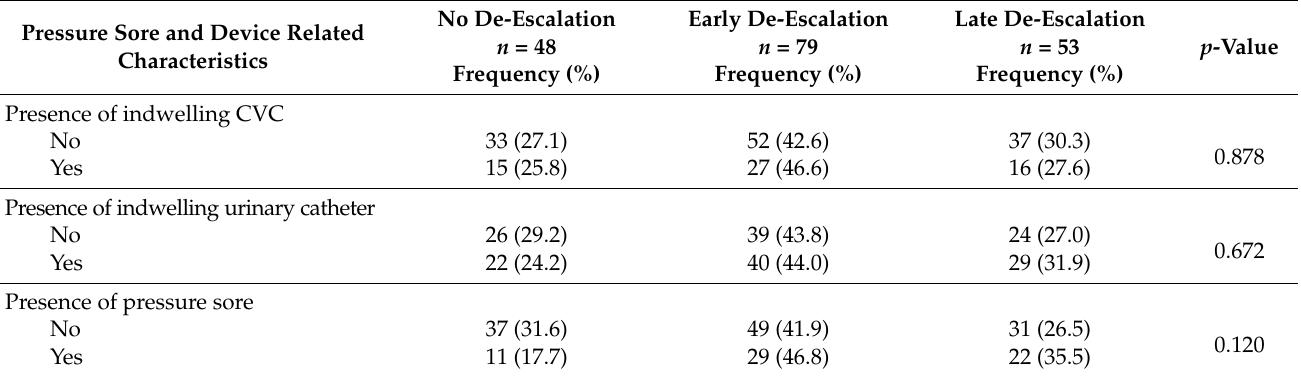
Table 3. Frequency distribution of pressure sore and device related characteristics based on de- escalation